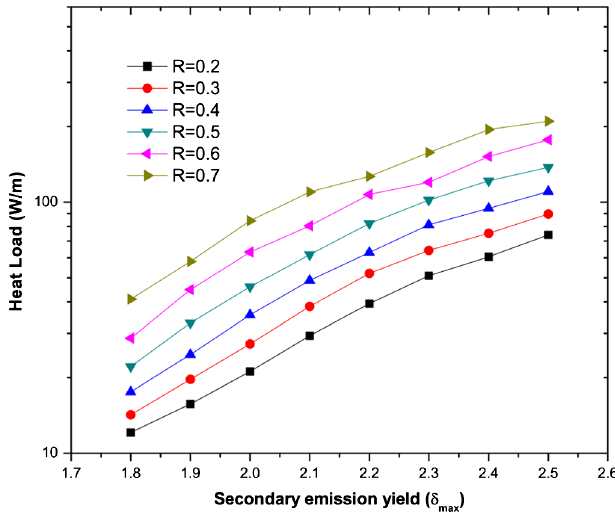
FIG. 9. Simulated average arc heat load for 50 ns bunch spacing at 3.5 TeV. Bunch population: 1 : 2 (cid:2) 10 11 ppb . During the corresponding experiment, an average heat load of about 45 mW = m was measured.